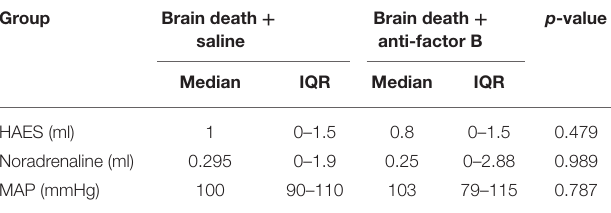
TABLE 1 | Overview of the fluids administered, when mean arterial pressure dropped below 80 mmHg, in rats during the 4h brain death period. p Group Brain death + Brain death + saline anti-factor B